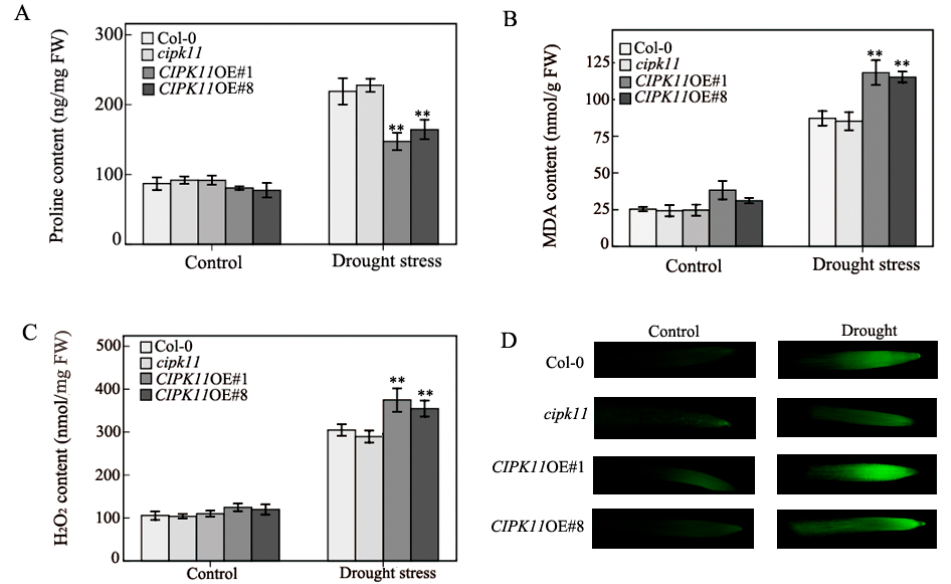
Figure 2. The overexpression of CIPK11 increases cell damage caused by drought stress ( A – C ) The relative Proline, MDA, and H 2 O 2 level in the Col-0, cipk11 , CIPK11 OE#1, and CIPK11 OE#8 were calculated under normal and drought stress conditions. Error bars indicate SE ( n = 3) and asterisks indicate significant di ff erences from the Col-0 using the unpaired Student’s t-test (* p < 0.05; ** p < 0.001). ( D ) Detection of ROS by using H 2 DCFDA. Roots from Col-0, cipk11 , CIPK11 OE#1, and CIPK11 OE#8 seedlings were subjected to liquid MS medium (Control) and exposed in room air for three minutes to simulate drought stress. The fluorescence of ROS (green) was imaged in the cells of root and the root images were collected after 15 min. incubation with H 2 DCFDA. Fluorescence indicates the presence of ROS.